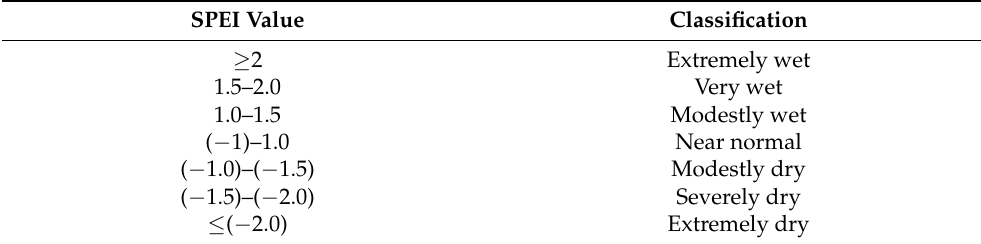
Table 2. Definition of the SPEI drought